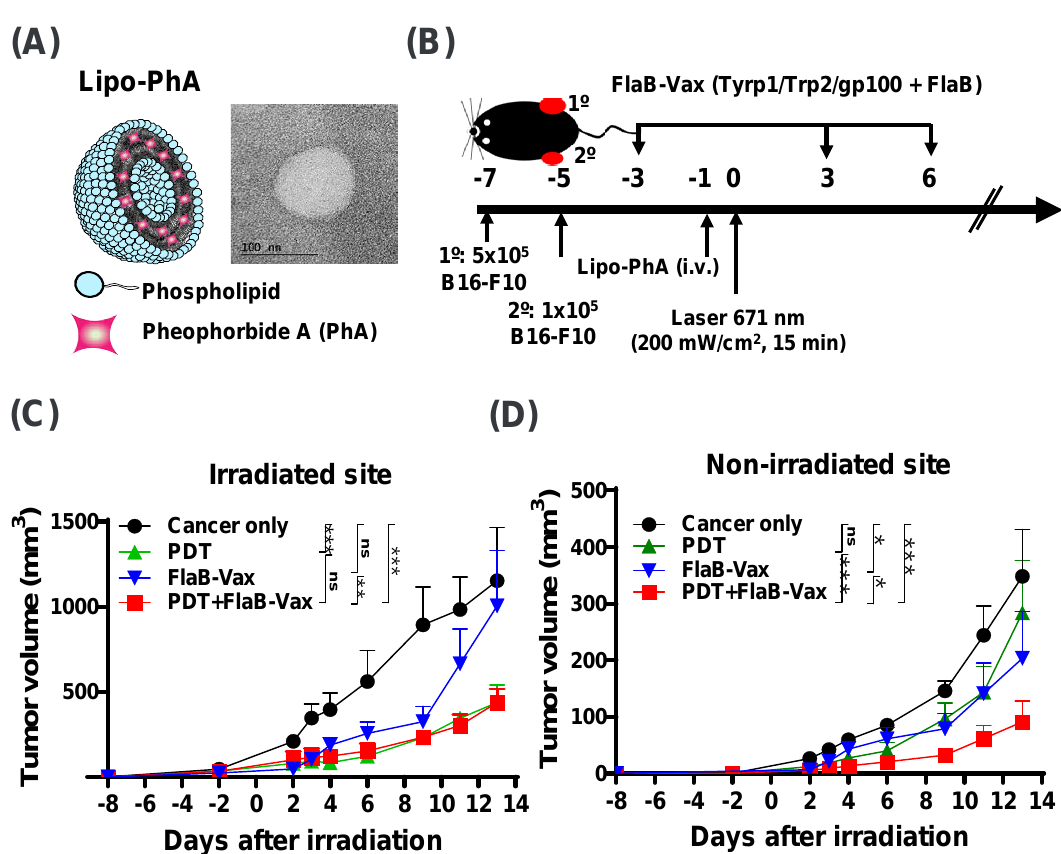
Figure 1. Inhibition of the growth of distant tumors in mice treated with photodynamic therapy (PDT) and flagellin-adjuvanted tumor-specific peptide vaccination (FlaB-Vax) at the primary tumor site. ( A ) Schematic illustration of pheophorbide A-loaded liposomes. Field-emission transmission electron microscopy (FE-TEM) images of liposome. ( B ) Schema of the PDT and FlaB-Vax combination therapy protocol. Growth of irradiated primary ( C ) and nonirradiated abscopal tumors ( D ) in mice treated with PDT, FlaB-Vax, or PDT + FlaB-Vax ( n = 5 per group). Asterisks indicate p values for the comparison of each group in irradiated tumors or nonirradiated tumors by two-way ANOVA. *, p < 0.05; **, p < 0.01; ***, p <